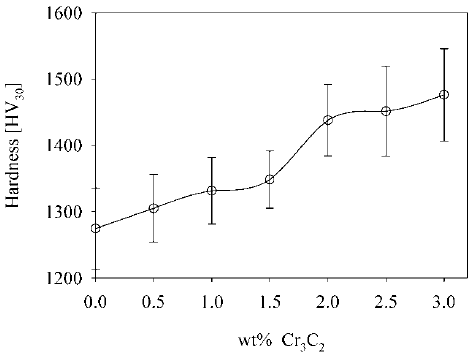
Figure 5. Effect of the Cr 3 C 2 addition on the hardness of the WC-10Co cemented carbide.